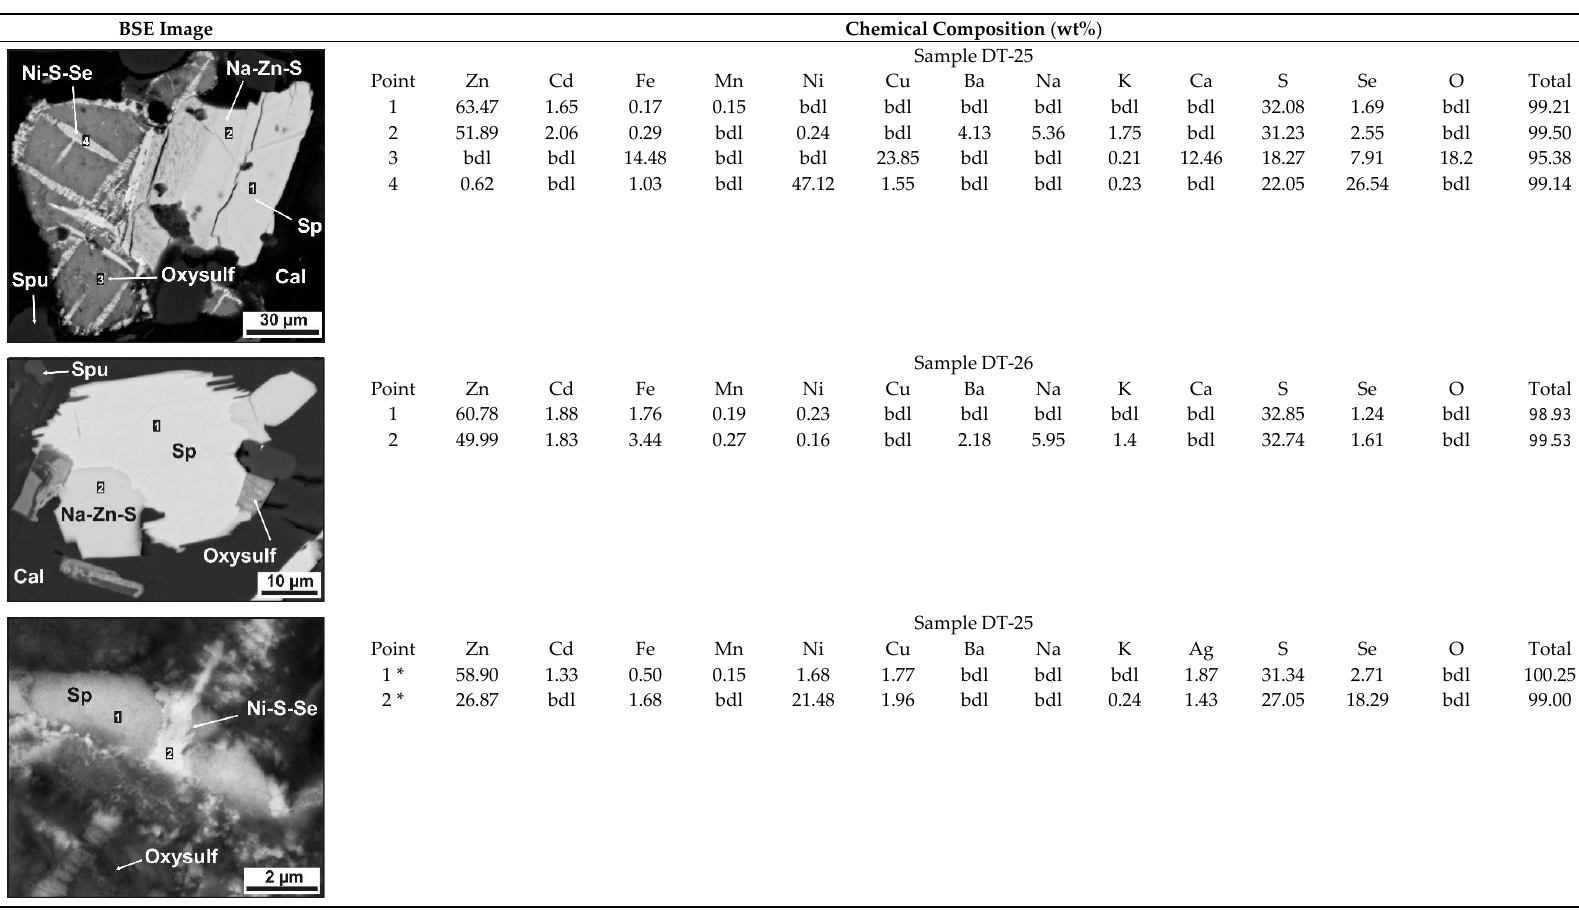
Table 6. BSE images and EDS compositions (wt%) of sphalerite and associated opaque minerals from the representative CM marble samples.